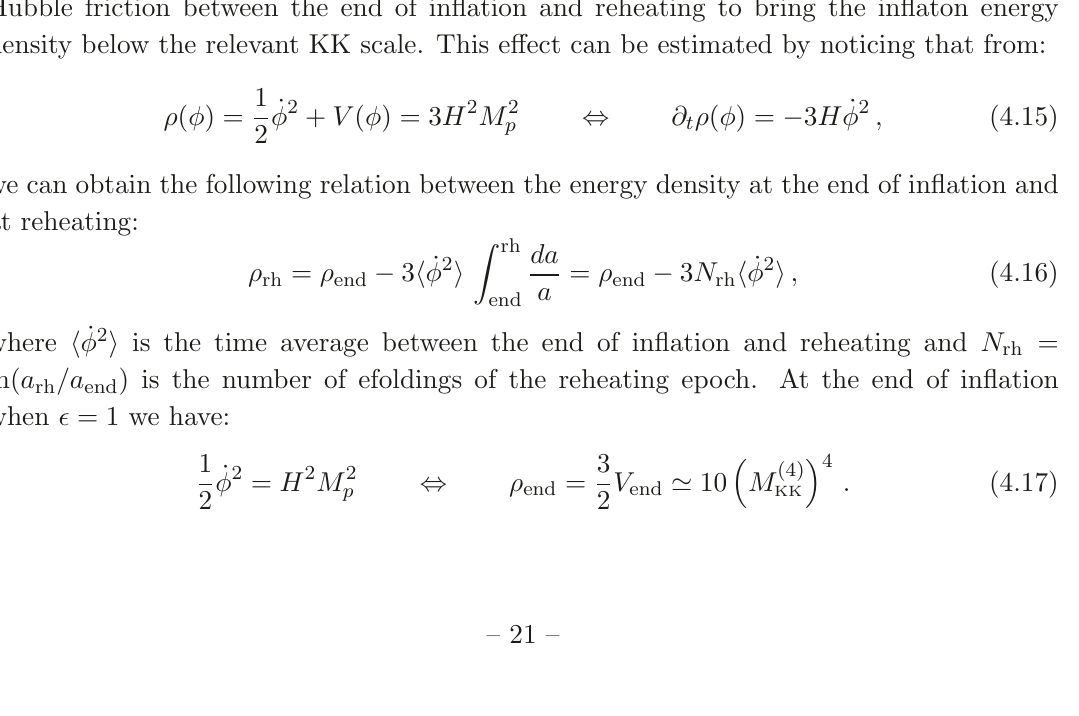
Figure 2 . Comparison between the different KK masses, m V 1 / 4 from horizon exit to the end of inflation. Note that M (4) them is displayed